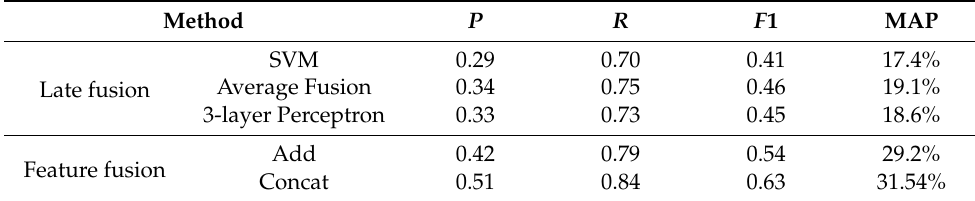
Table 4. Comparison of experimental results of different feature combination